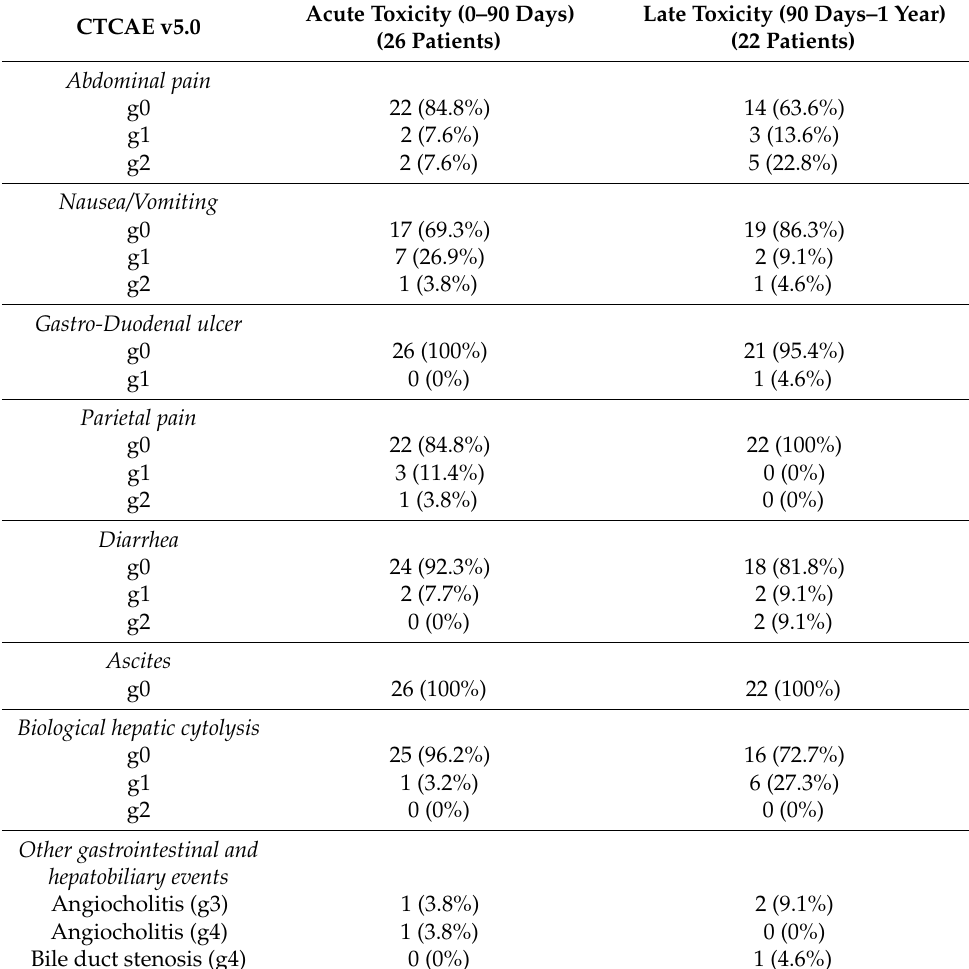
Table 3. Acute and late clinical events following liver